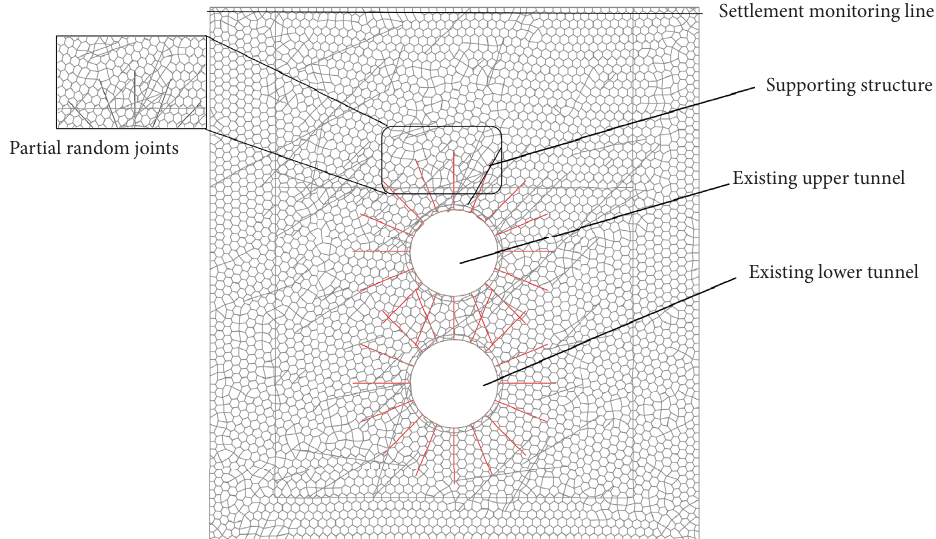
Figure 3: Tunnel model grid. Table 3: Simulation scheme.